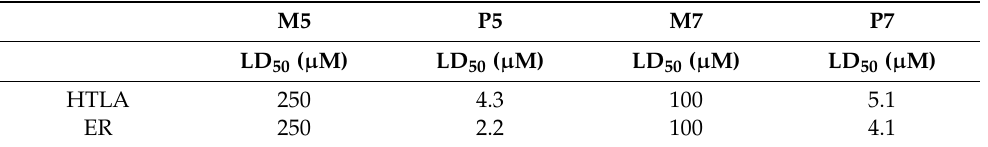
Table 6. Values of LD 50 computed for monomers M5 and M7 and for copolymers P5 and P7, considering the results obtained by dose-dependent cytotoxic essays.